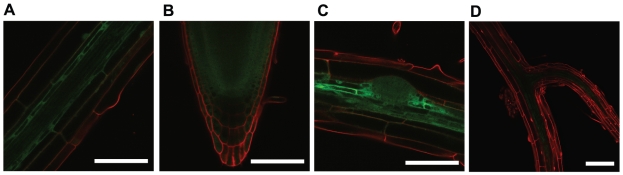
Pattern of expression of the FRY1-GFP fusion protein in roots.Roots of a fry1-7 mutant complemented with a pFRY1:FRY1:GFP construct were observed by confocal microscopy. (A) Mature root. (B) PR meristem. (C) LR primordium. (D) Emerged LR. Scale bars are 75 µm in A, B and C, and 150 µm in D.